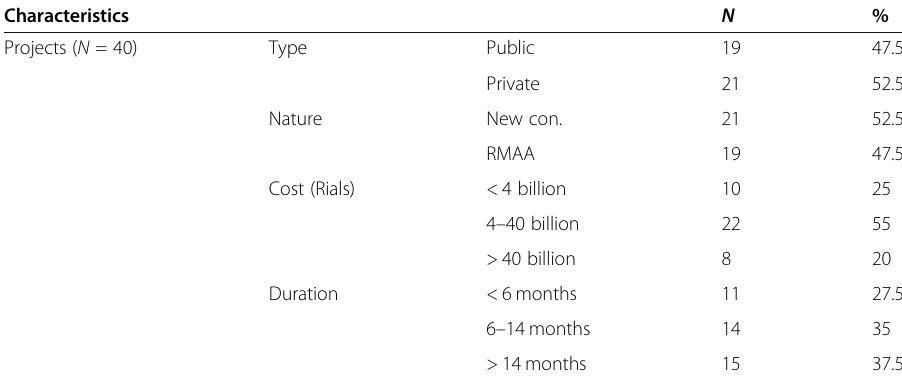
Table 4 The project details carried out by each company separately Characteristics